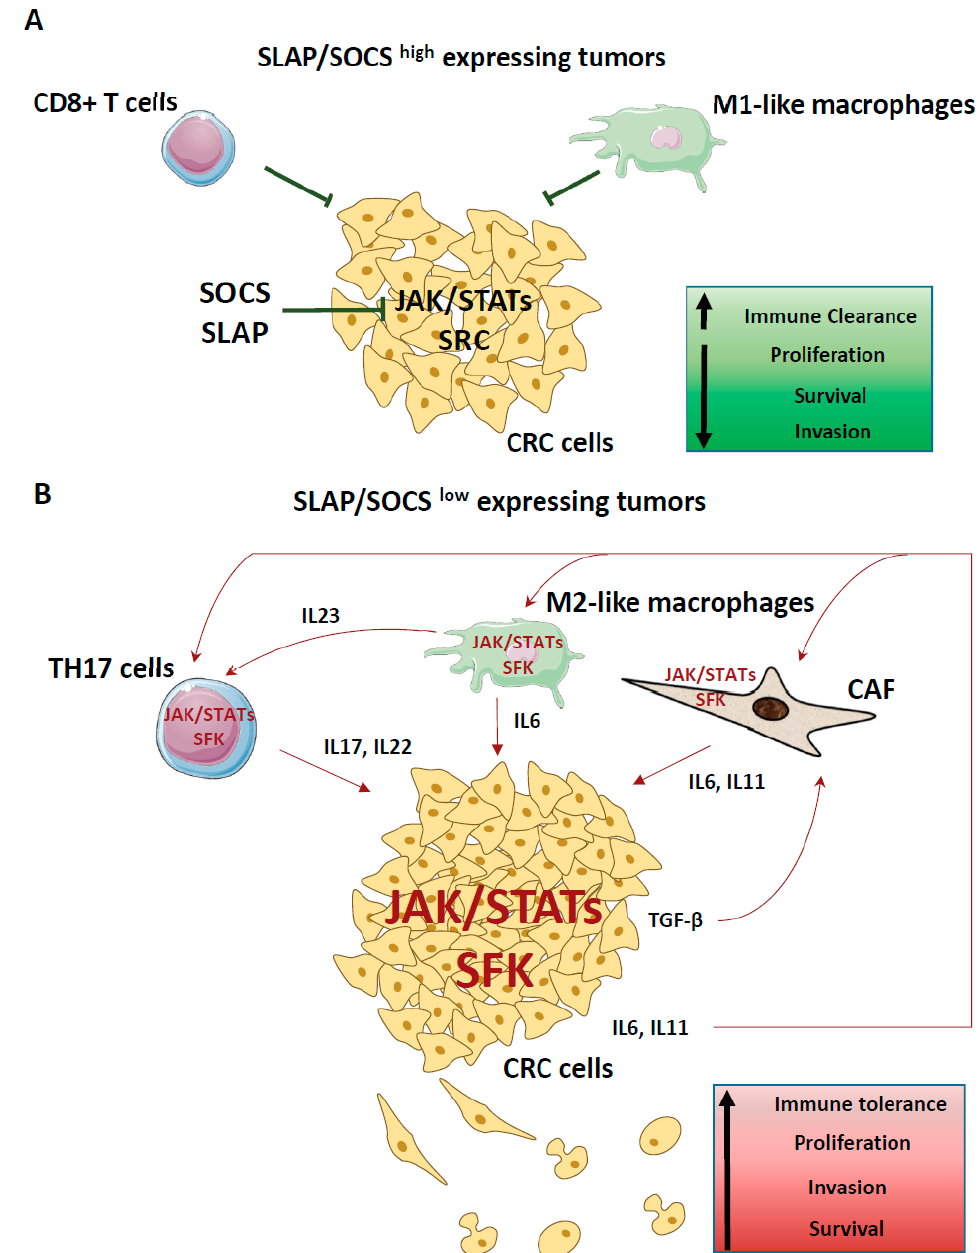
Figure 4. Model describing how SLAP and SOCS adaptors modulate SRC- and JAK-dependent tumour activities in CRC. ( A ) High SLAP and SOCS expression level in CRC limits JAK inflammatory and SRC / JAK tumour signalling, resulting in increased immune clearance and reduced tumour cell growth and invasion. ( B ) Downregulation of these adaptors results in enhanced JAK inflammatory and JAK / SRC tumour signalling and, consequently, higher tumour immune tolerance and tumour cell growth and